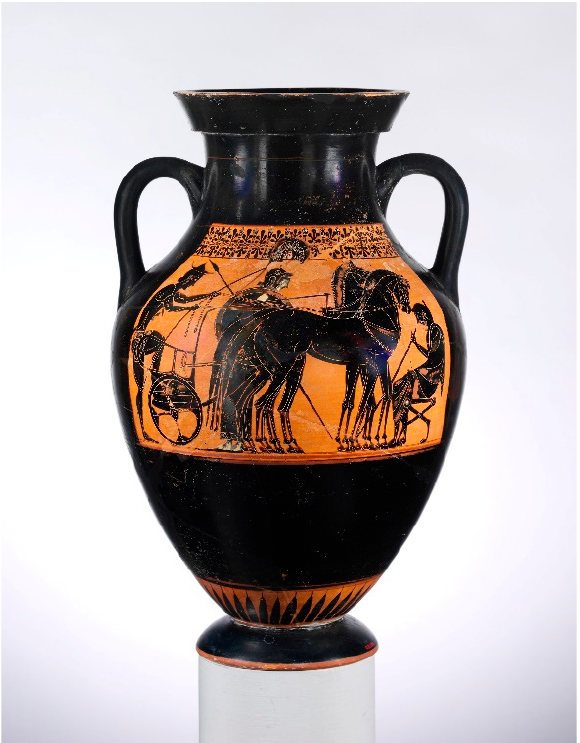
Figure 7. Amphora attributed to the manner of the Lysippides Painter. Ca. 530 BCE. Metropolitan Museum of Art. Inv. no. Y.21.26.